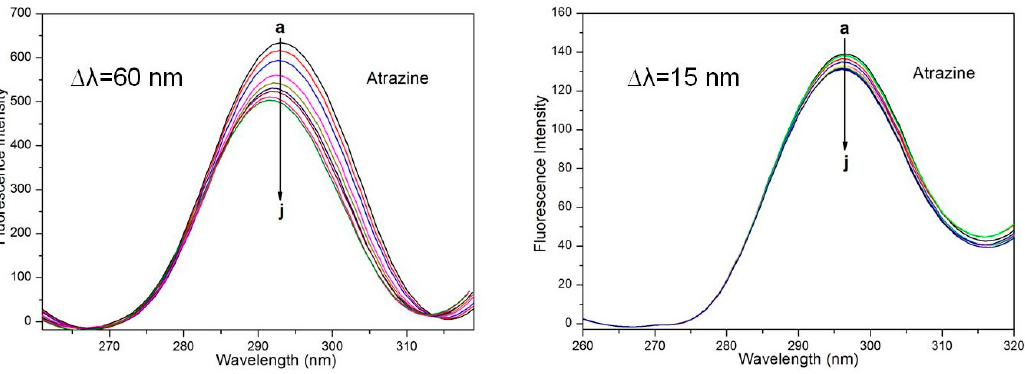
Figure 7. Synchronous fluorescence spectra of HSA with various amounts of ATR.